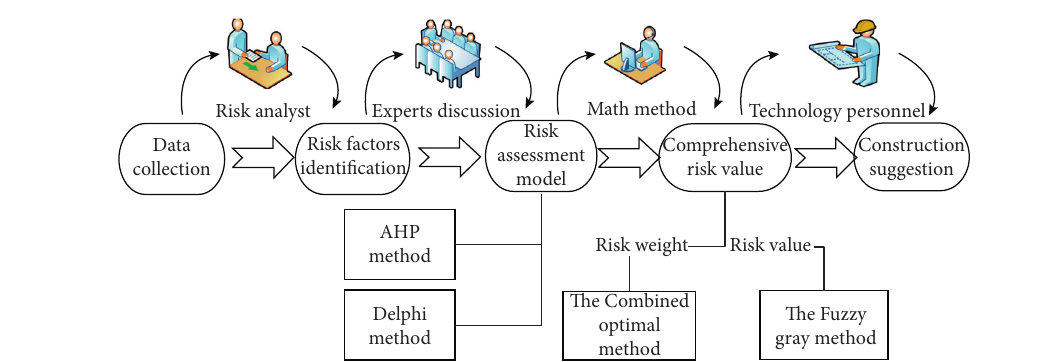
Figure 2: Safety assessment process.